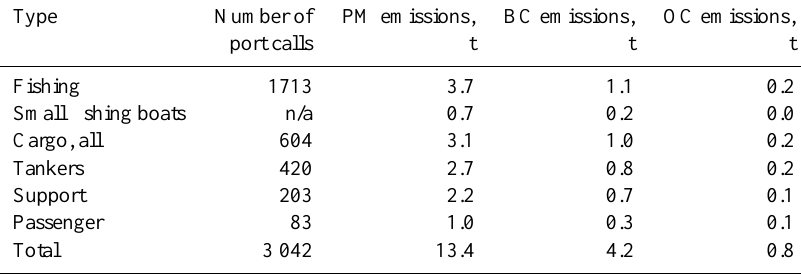
Table 5. Number of port calls and emissions from ships. “n/a” means not available. Type Number of PM emissions, BC emissions, OC emissions, port calls t t t Fishing 1713 3.7 1.1 0.2 Small fishing boats n/a 0.7 0.2 0.0 Cargo, all 604 3.1 1.0 0.2 Tankers 420 Support 203 0.1 Passenger 83 Total Source: Murmansk Port,